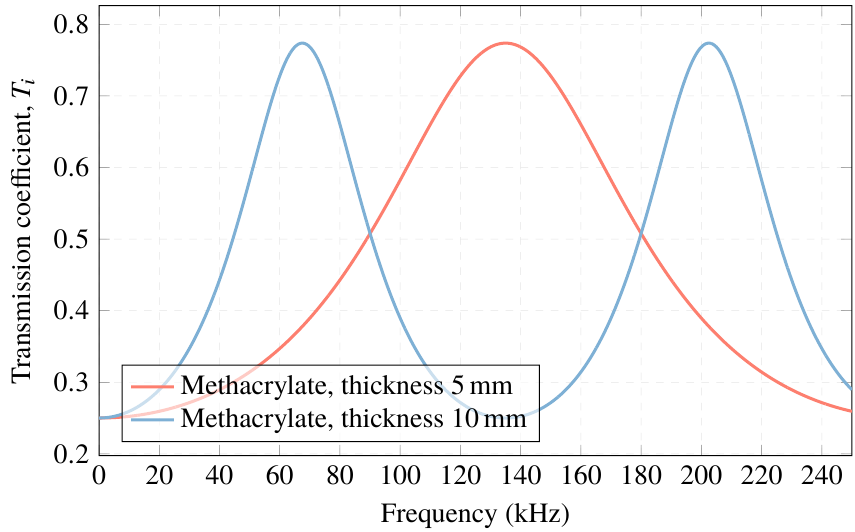
Figure 5. Acoustic transmission coefficient with a methacrylate matching layer.